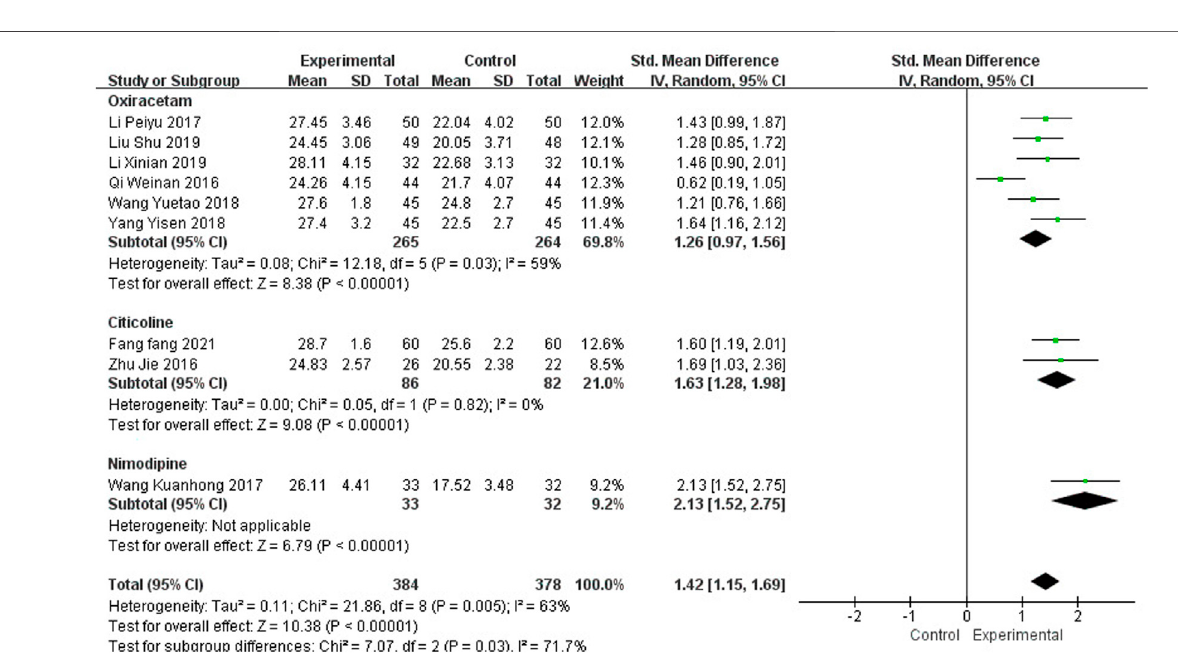
FIGURE 6 | Meta-analysis of MMSE by NBP as combination therapy.